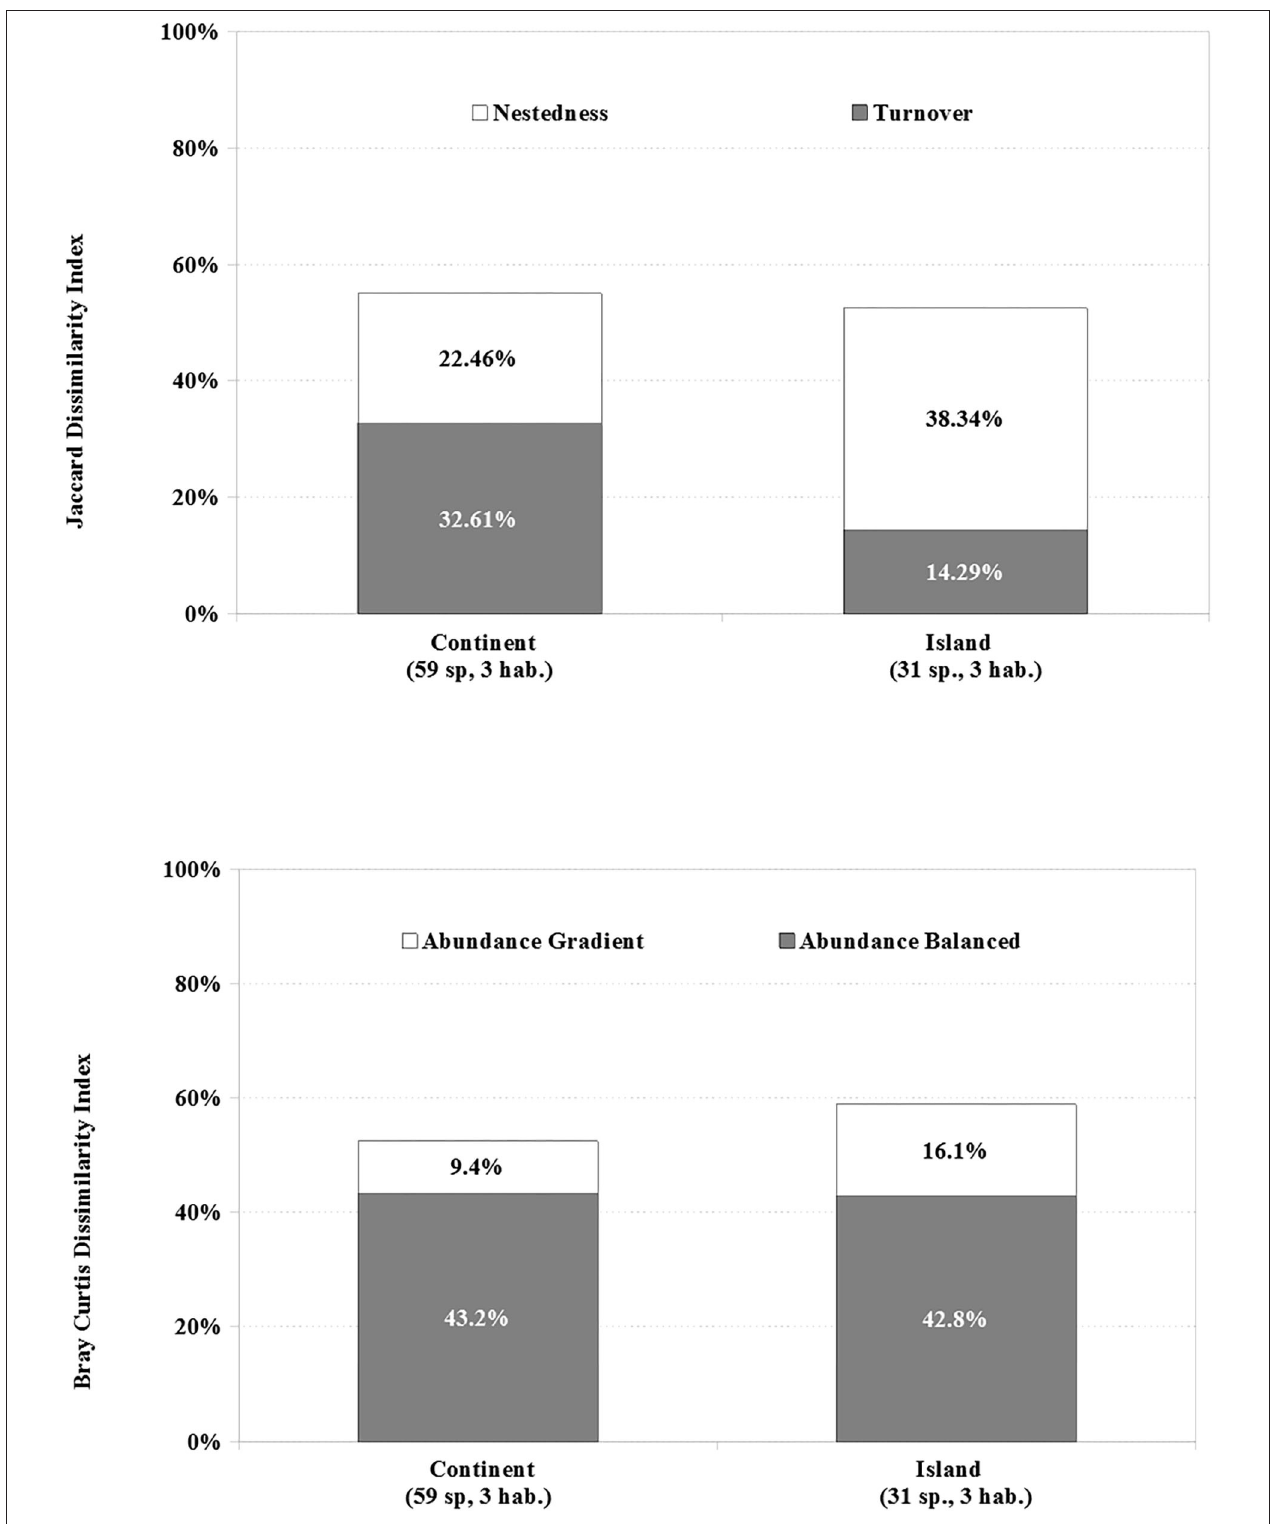
FIGURE 3 | Mean values of the index of incidence-based dissimilarity (Jaccard) and abundance-based dissimilarity (Bray–Curtis) among W, MD, and HD sectors, in each region with 31 and 59 widespread species recorded at Island and Continent, respectively.